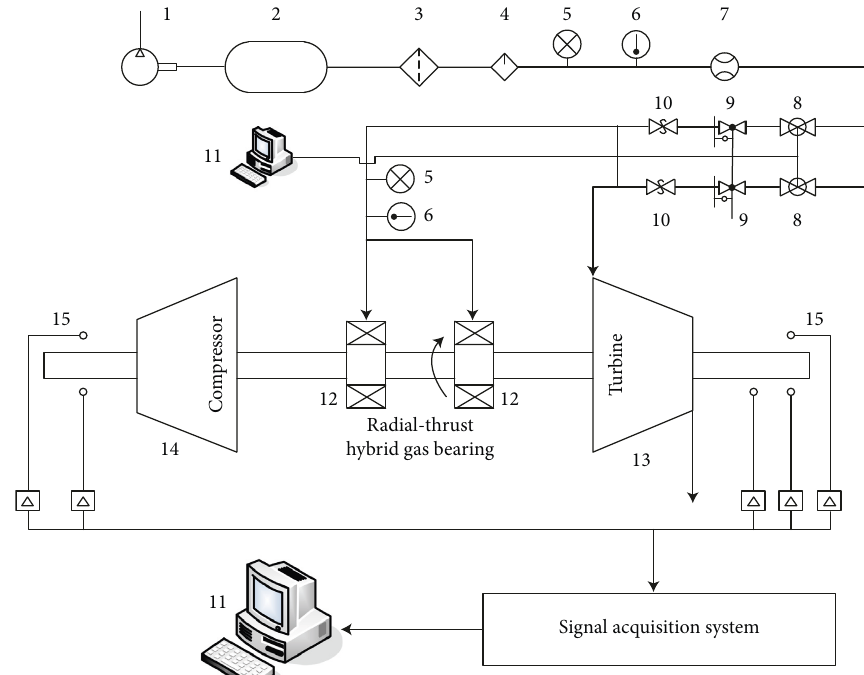
Figure 16: Sketch map for ACM test rig. (1) Air compressor, (2) gas tank, (3) filter, (4) dryer, (5) pressure gauge, (6) thermometer, (7) flow meter, (8) pressure stabilizing valve, (9) electropneumatic air regulator, (10) safety shut-off valves, (11) computer, (12) radial-thrust hybrid gas bearing, (13) turbine, (14) data acquisition, and (15) eddy current displace